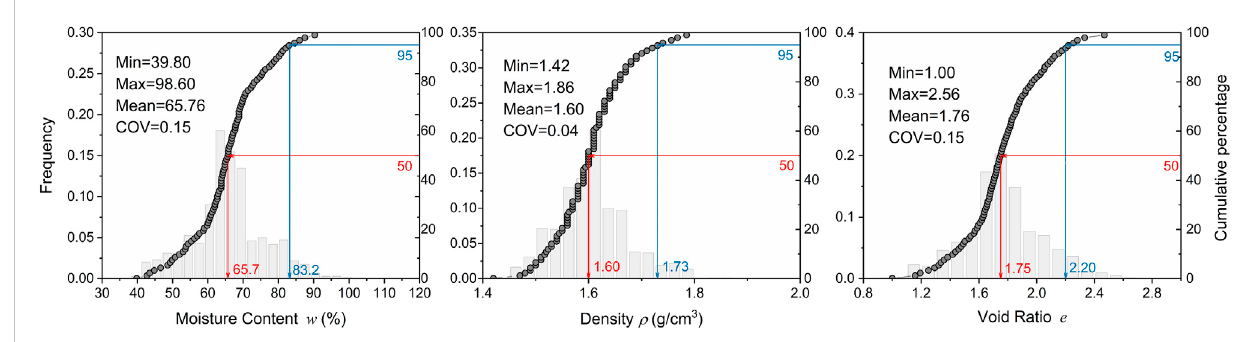
FIGURE 4 Histograms and cumulative distributions of the physical parameters ( ω , ρ , e ) in CP tests.